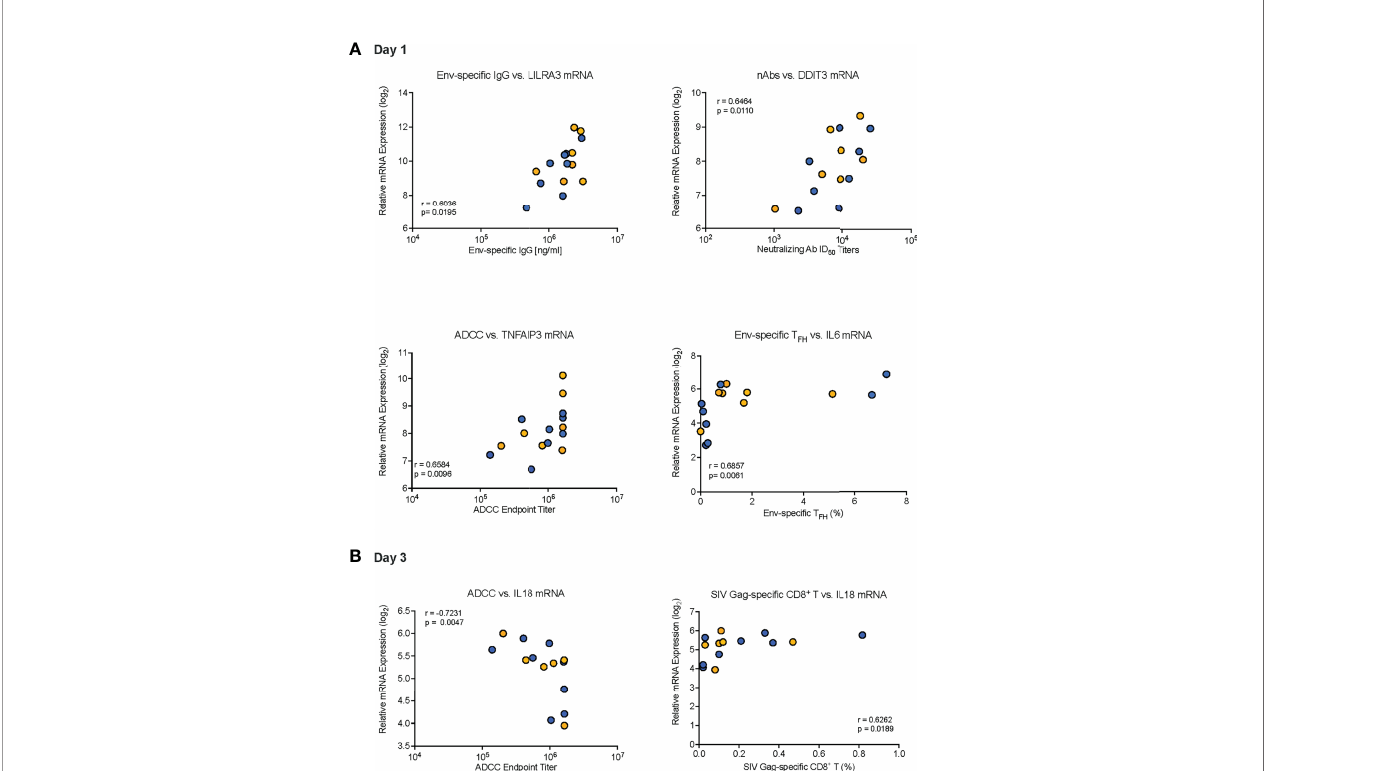
FIGURE 8 | Examples of correlations between day 1 or day 3 innate immune responses and adaptive immune responses. Representative examples of correlations between innate immune responses on Day 1 (A) or Day 3 (B) with distinct adaptive immune responses are presented. (A) Correlation between (i) Env-speci fi c IgG at week14 andD1LILRA3 mRNA expression,(ii) neutralizingID50 titersat week 34 and D1DDIT3 mRNA expression,(iii) endpoint ADCC titersatweek 34 and D1TNFAIP3 mRNA, and (iv)week 34 Env-speci fi c T FH frequencies and D1IL6mRNA expression. (B) Correlation between (i) week 34 ADCC endpoint titersand D3 IL18 mRNA levels and(ii) week 34 SIV Gag-speci fi c CD8 + T cellfrequencies andD3IL18 mRNA levels. Each symbol represents an individualanimalof Group 1 (orange circles) or Group 2 (blue circles). The “ r ” and “ p ” values were determined bySpearman rank analysis andrepresent the correlation coef fi cient andthe unadjusted p values,